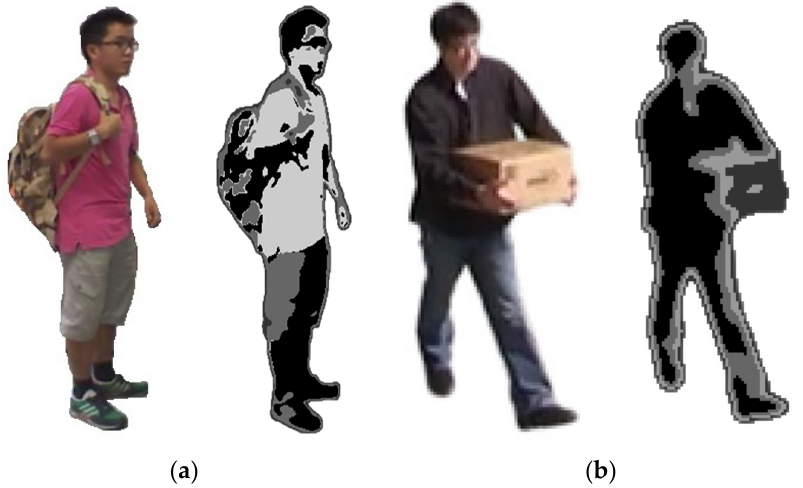
Figure 7. Texton maps of silhouettes from SYSU 3D HOI and VIRAT Video datasets: ( a ) wearing backpack—full silhouette ( left ) and its texton map ( right ) and ( b ) carrying an object—full silhouette ( left ) and its texton map ( right ).